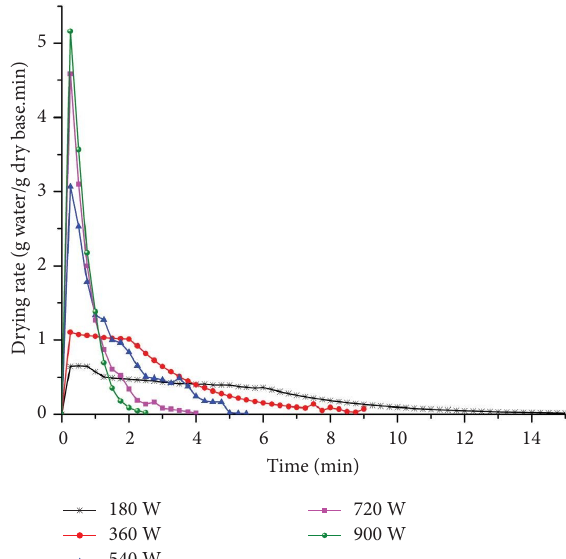
Figure 3: Variation of drying rate during microwave drying of Stevia leaves at diferent